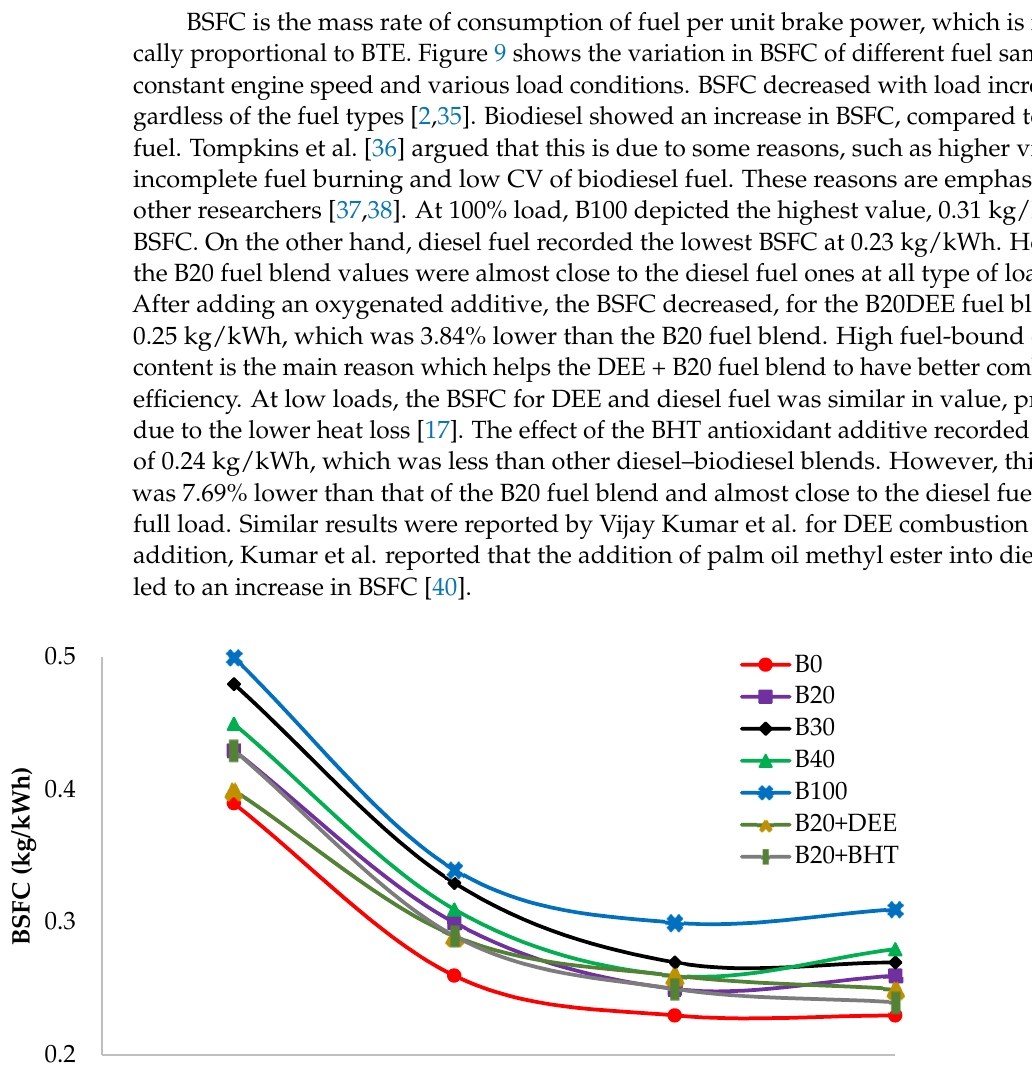
0.20.30.40.5 Figure 9. BSFC of all fuel blends at different engine Figure 9. BSFC of all fuel blends at different engine loads. Figure 10. NO X emission of all fuel blends at different engine loads. From Figure 10, the results indicate that B20, B30 and B40 had a higher NOx emission than diesel fuel. This could be attributed to the biodiesel high molecule weight and also to the presence of high oxygen content, which increases the temperature locally, resulting in higher emissions of NOx [31,35]. The values of NOx emission of B100, B0, B20, B30, B40, B20BHT and B20DEE were 1714, 1855, 1879, 1886, 1796, 1494 and 1583 ppm, respectively. For the B20 blend, the NOx emission was slightly greater than diesel by 1.3%, whereas the NOx emission of B100 was 7.6% less than diesel fuel. The presence of DEE in B20